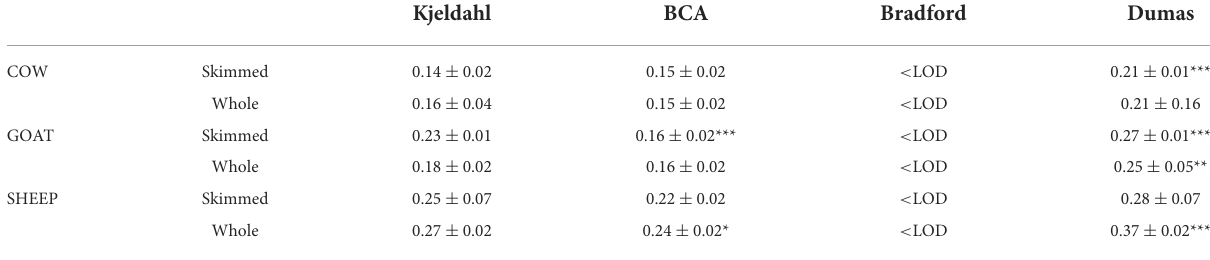
TABLE 3 Comparison of total protein content in permeate samples (g/100mL) determined by Kjeldahl official reference method with the bicinchoninic acid assay (BCA), the detergent compatible Bradford assay and the Dumas method. Kjeldahl BCA Bradford Dumas COW